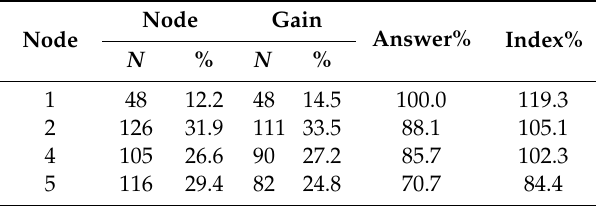
Table 12. Earnings for nodes: target those who do use Twitter.